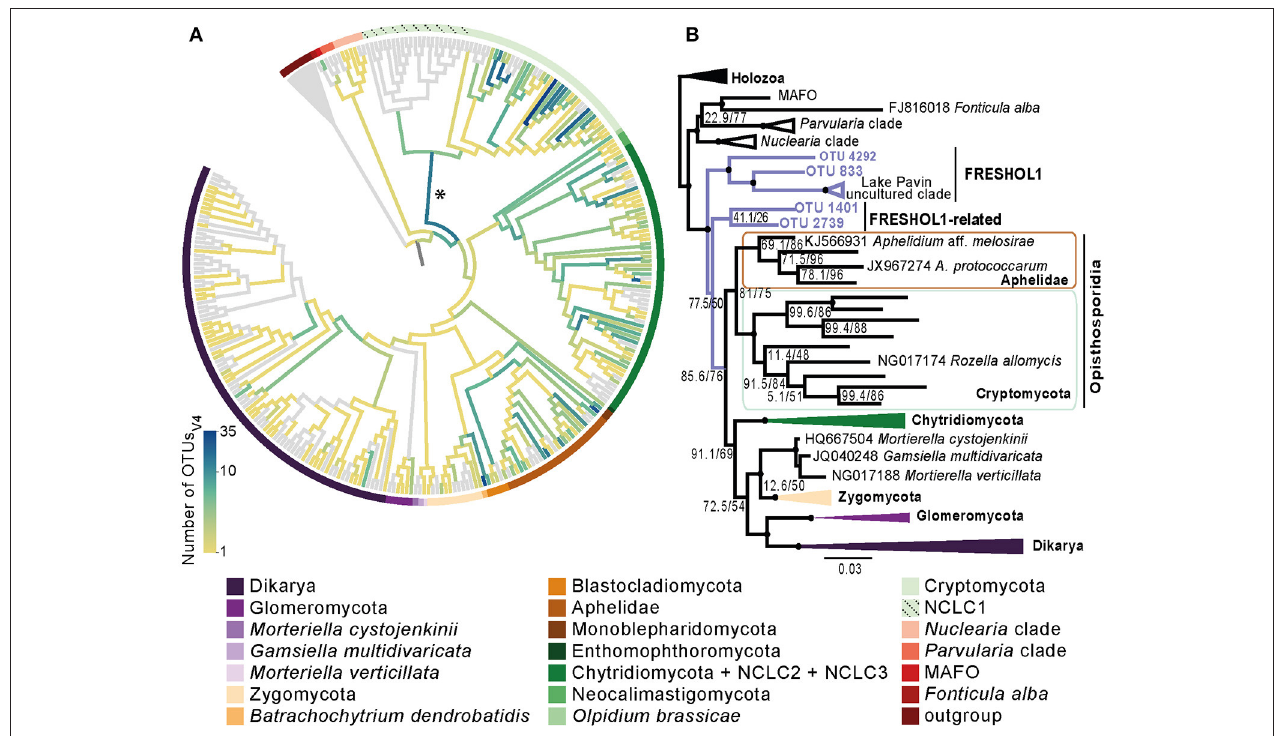
FIGURE 3 | Diversity and novelty of Holomycota OTUs of the V4 region. (A) Mapping of all Holomycota OTUs V4 into our reference tree. The darker the branch, the higher amount of OTUs V4 it contains, as it is depicted in the reference bar. Taxonomic assignment is shown by color code indicated in the panel below. Early-diverging fungal groups, such as Cryptomycota and Chytridiomycota hold the majority of the Paraná Holomycota diversity. An asterisk indicates an assemblage of putatively novel OTUs V4 , whose phylogeny is shown in (B) . (B) Maximum-likelihood tree showing the phylogenetic placement of novel OTUs V4 found in our Paraná dataset in relation to Holomycota and other opisthokont lineages including the environmental clade identified from Lake Pavin ( Monchy et al., 2011). We term this group FRESHOL1 (for freshwater Holomycota). We also named the closest group as FRESHOL1-related. The tree was obtained using IQ-tree software under GTR evolutionary model with nodal supports (SH-aLRT and UFBoot support) obtained through 1,000 bootstrap replicates ( Nguyen et al., 2015). Black dots are depicted when SH-aLRT > 80% and UFBoot > 95%. Full alignment and tree can be found in Supplementary Datasheet